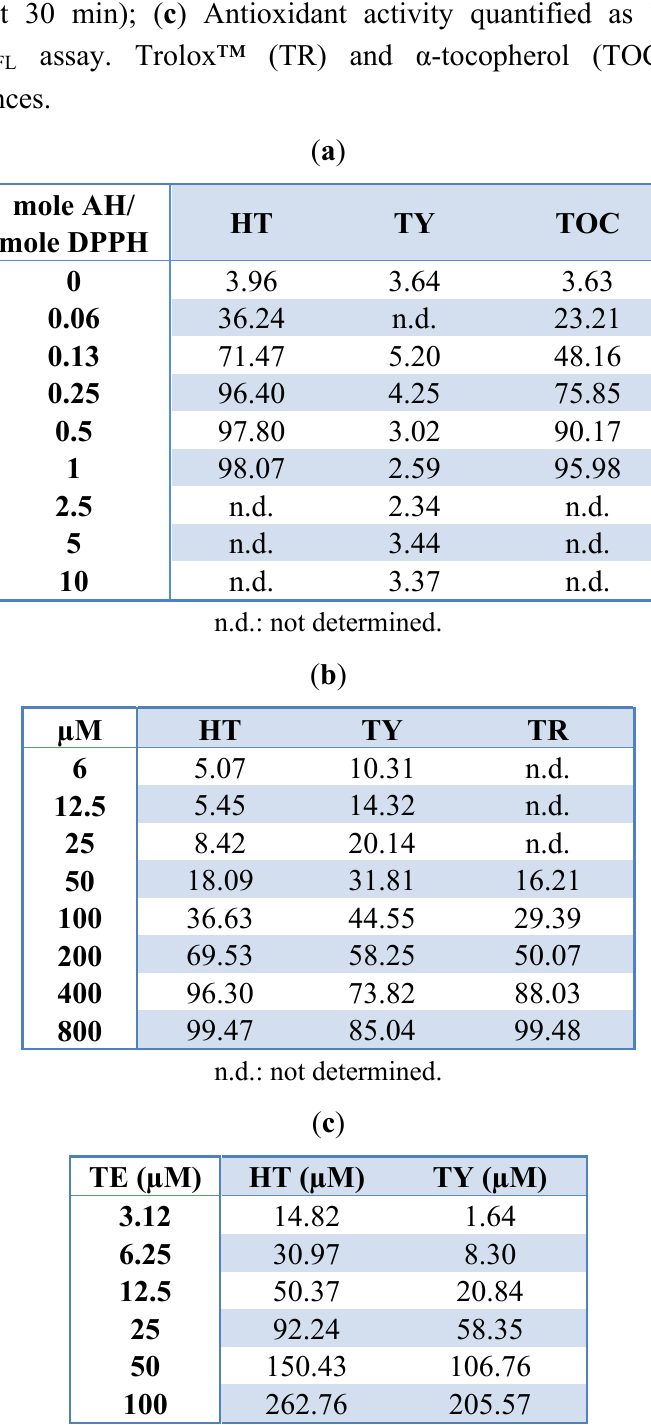
Table 1. Antioxidant activity of hydroxytyrosol (HT) or tyrosol (TY) quantified